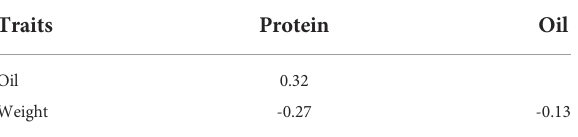
TABLE 3 Phenotypic correlations between seed nutritional traits and weight in sorghum.